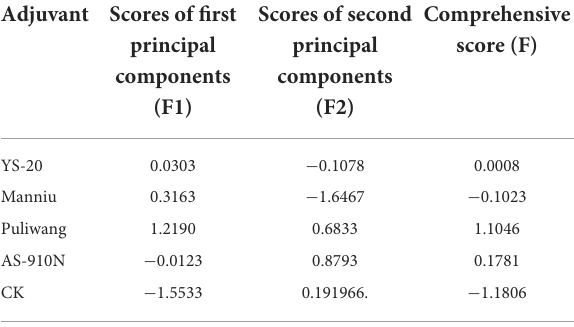
TABLE 8 Comprehensive score of adjuvant performance. Adjuvant Scores of